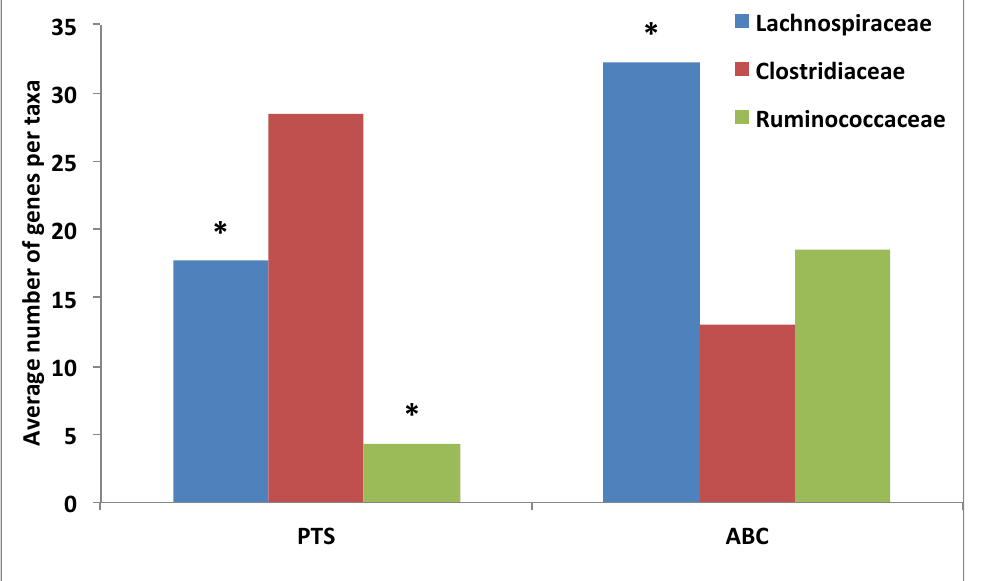
Figure 7. A comparison of the average abundance of phosphotransferase system (PTS) and ATP-binding cassette (ABC) transporter genes in Lachnospiraceae, Clostridiaceae, and Ruminococcaceae genomes from the IMG database [27]. (*) Genes showing significant differences between groups (Clostridiaceae as reference) in best fit between negative binomial or Poisson regression models as determined by the likelihood ratio test ( p -value <